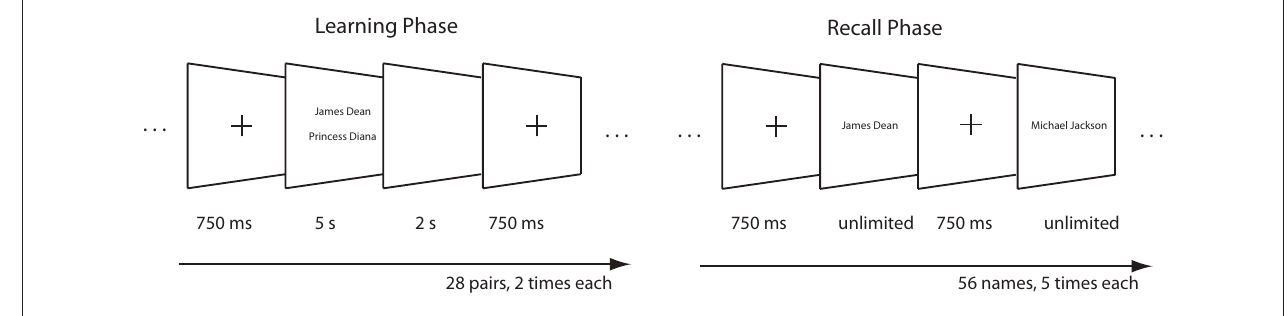
Figure 5 | experimental procedure in experiment